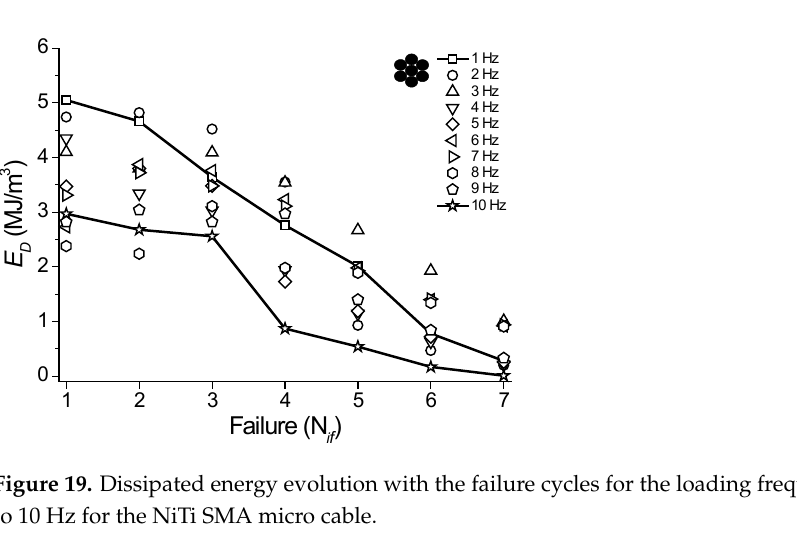
18 of 22 Figure 18. Stress vs. strain superelastic response of the reference element for loading frequencies from 7 Hz to 10 Hz. As observed, for frequencies 1 Hz and 2 Hz the peak stresses for the last cycle (the 2097th and the 4194th, respectively) are lower than for the first cycle. The peak stresses for the 2097th and for the first cycles are 495.8 MPa and 532.27 MPa, respectively, for the frequency of 1 Hz, a reduction of approximately 6.8%. At 2 Hz, the peak stresses for the 4194th and for the 1st cycles are 511.64 MPa and 545.1 MPa, respectively, a reduction of approximately 6.1%. From 3 Hz to 6 Hz, the peak stresses values referring to the 2n cycles increase throughout cycling, with a negligible difference between the first and last cycles. How- ever, from 7 Hz the last cycle remains above the first cycle, indicating a severe condition of mechanical loading, which leads to a rapid degradation of the functional properties of the reference element. The functional fatigue of the NiTi SMA micro cable was also evaluated, based on the superelastic loop evolution shown in Figures 15 and 16. From this, Figure 19 shows the